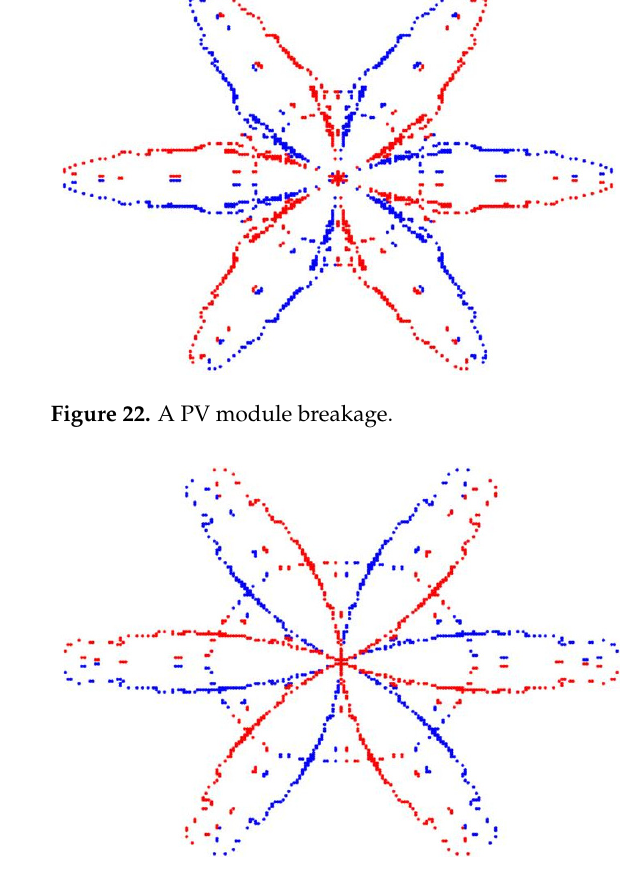
Figure 23. A PV module diode bypass failure .